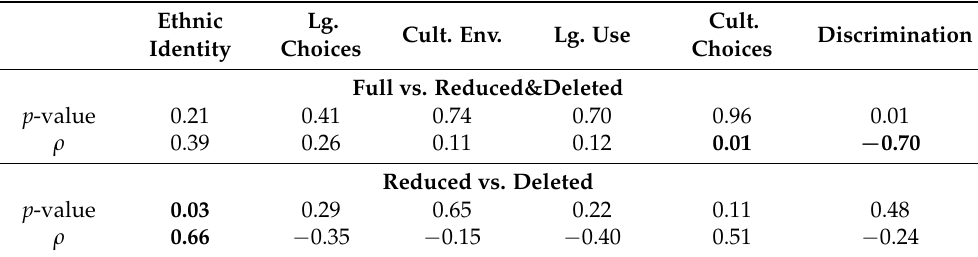
Cult. Discrimination Choices